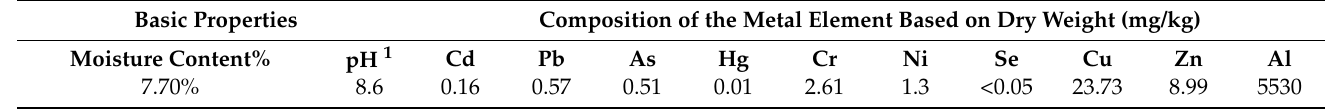
Figure 2. ( a ) Physical appearance; ( b ) SEM image of the WPFs. Table 1. Basic properties and proportions of toxic metal elements in